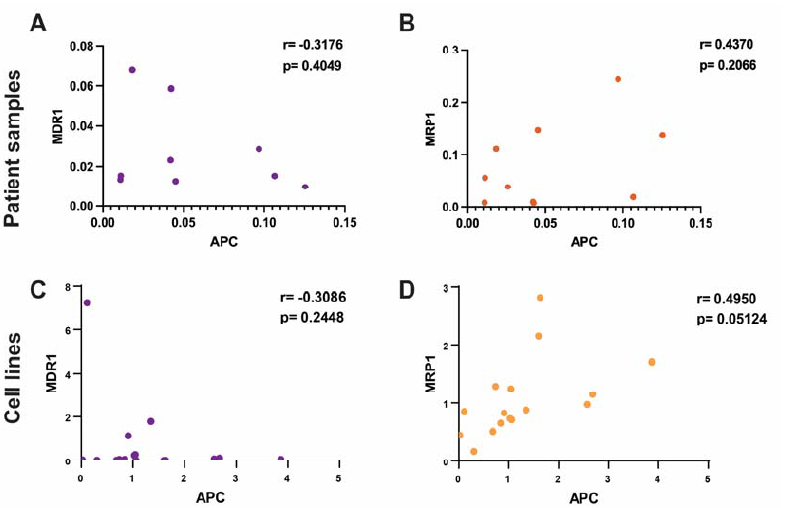
Figure 2. Correlation of APC with DOX sensitivity and the expression levels of MDR1 and MRP1 in human breast cancer. ( A ) Using patient tumor samples, the expression of APC was correlated with MDR1 expression levels. Protein levels were normalized to the normal epithelial cell lines. Lower levels of APC protein trended with higher levels of MDR1 protein (Pearson’s r = − 0.3176) but this trend was not significant ( p = 0.4049). ( B ) In the patients’ tumor samples, the protein level of APC was not significantly correlated with MRP1 protein levels. Higher APC protein levels trended with higher MRP1 protein levels, but this was not significant (Pearson’s r = 0.4370; p = 0.2066). ( C ) In a panel of human breast cancer cell lines, the expression levels of APC were correlated with the protein expression levels of MDR1 and MRP1. Protein levels were normalized to the average of the normal breast epithelial cell lines. Decreased APC levels trended with increased MDR1 levels (Pearson’s r = − 0.3086), but the trend was not significant ( p = 0.2448). ( D ) Increased APC protein levels correlated with increased MRP1 protein levels (Pearson’s r = 0.4950; p = 0.05124).